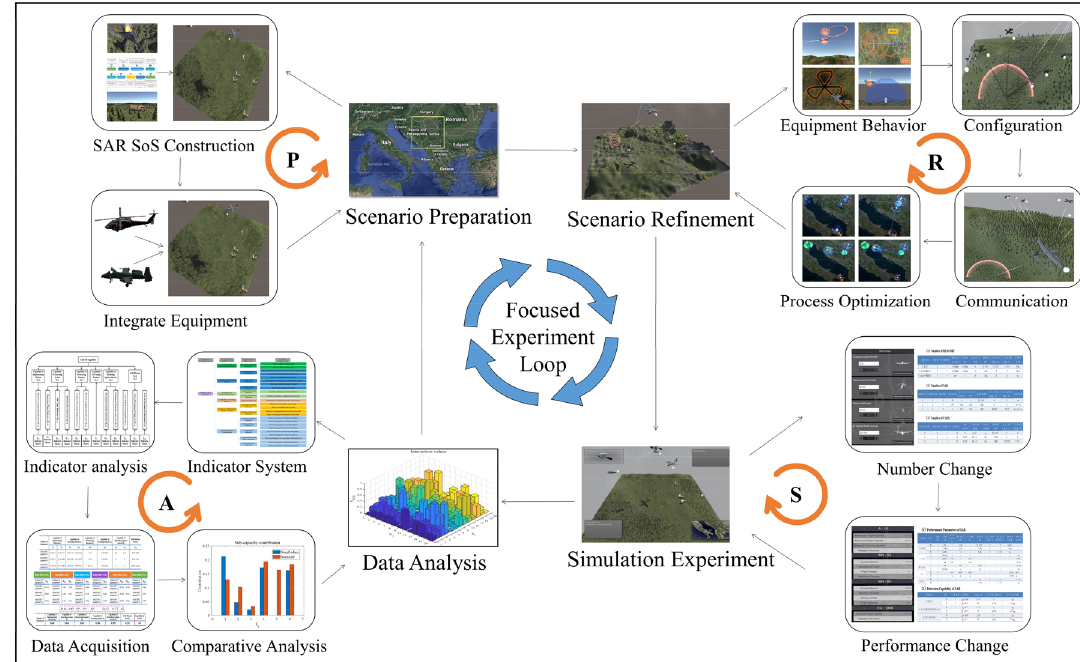
Figure 4. PRSA focused experiment loop.